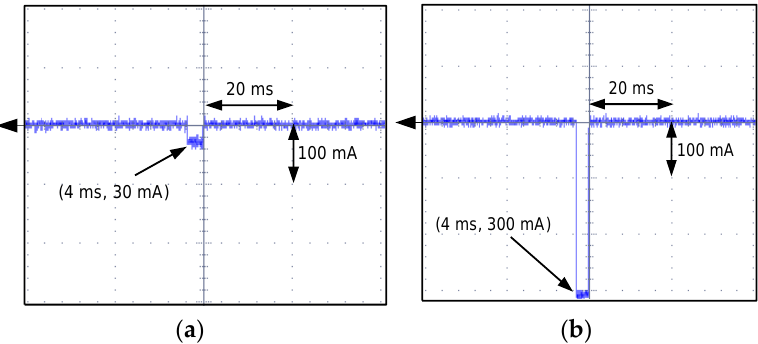
Figure 25. Oscillograms of the DC current flow during the tripping test of the A-type RCD (RCD30_1). Suddenly applied DC current of the following values: ( a ) 30 mA; ( b ) 300 mA.